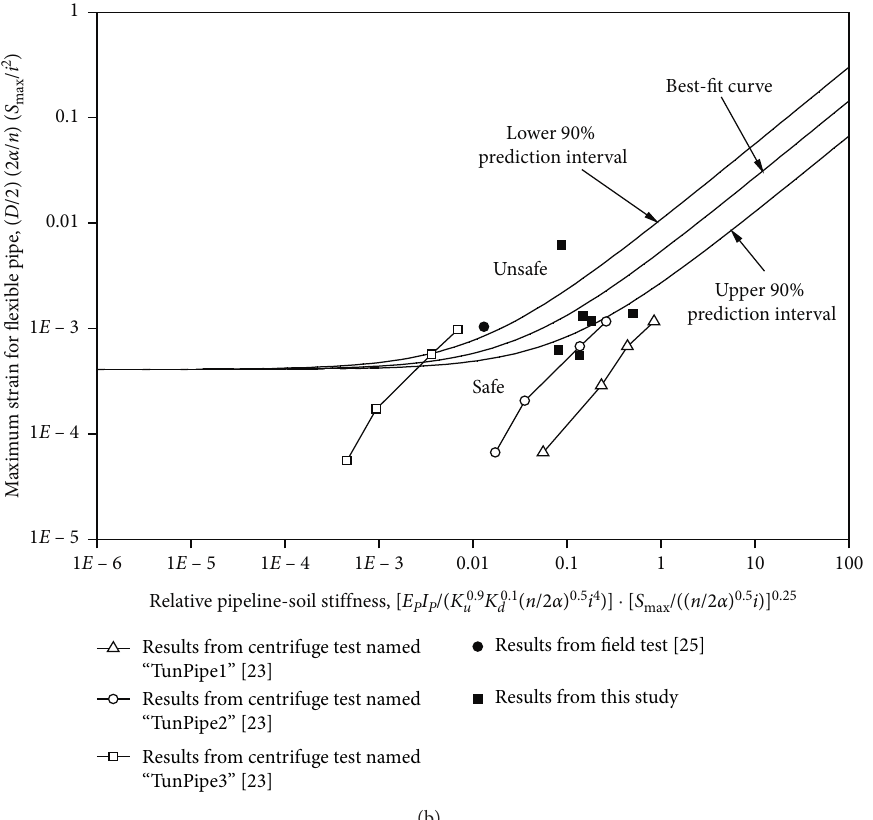
Figure 11: Illustration of pipeline safety criteria due to tunneling: (a) ε